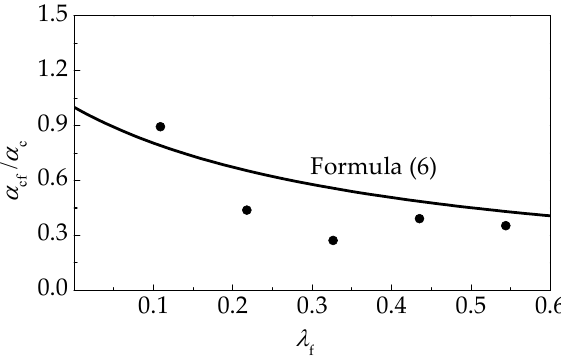
Figure 15. Relationship between λ f and α cf / α c.